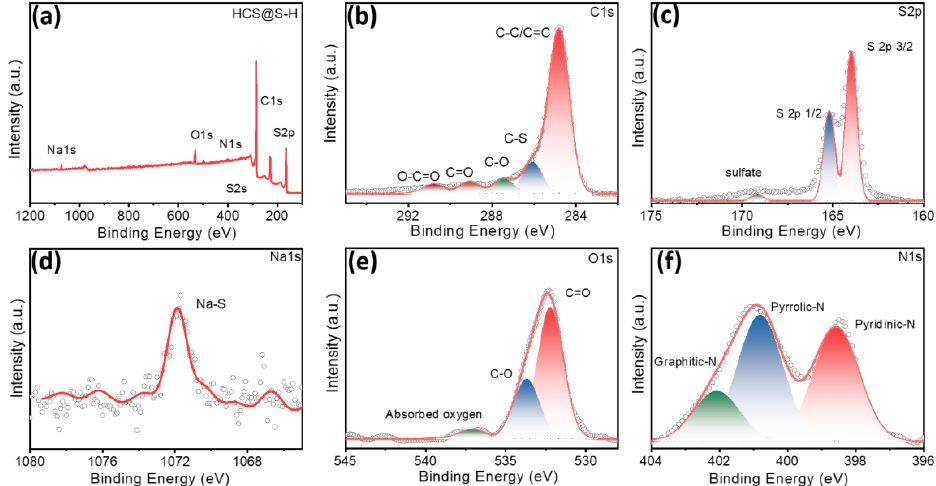
Figure 2. XPS spectra of HCS@S-H: Full spectra ( a ), C1s ( b ), S2p ( c ), Na1s ( d ), O1s ( e ) and N1s ( f